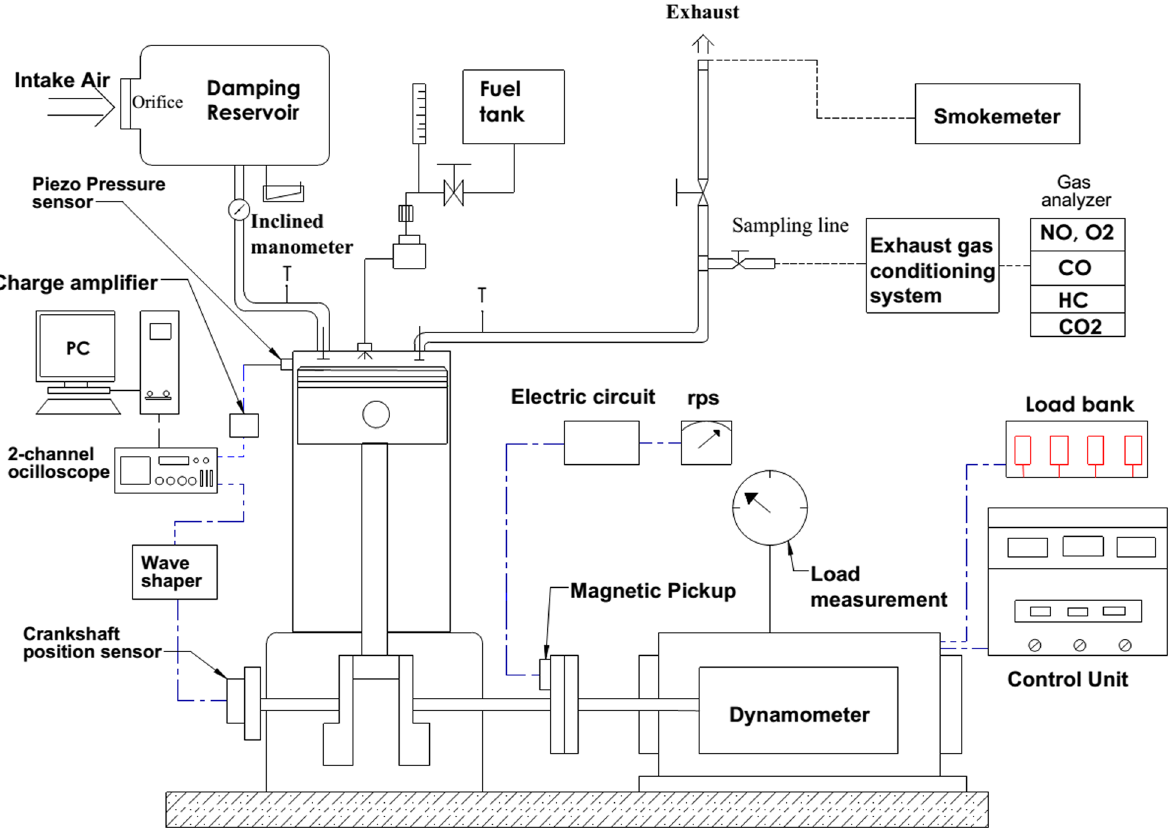
Fig. 1 Schematic diagram of the engine test